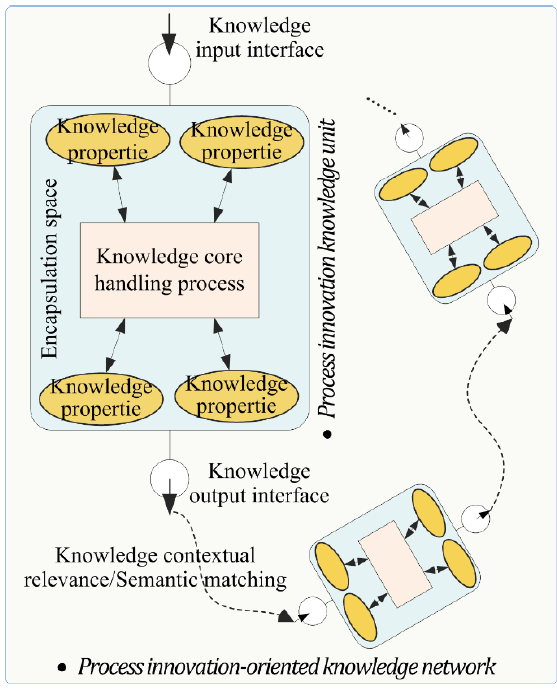
Figure 2. Schematic diagram of process innovation-oriented knowledge network.